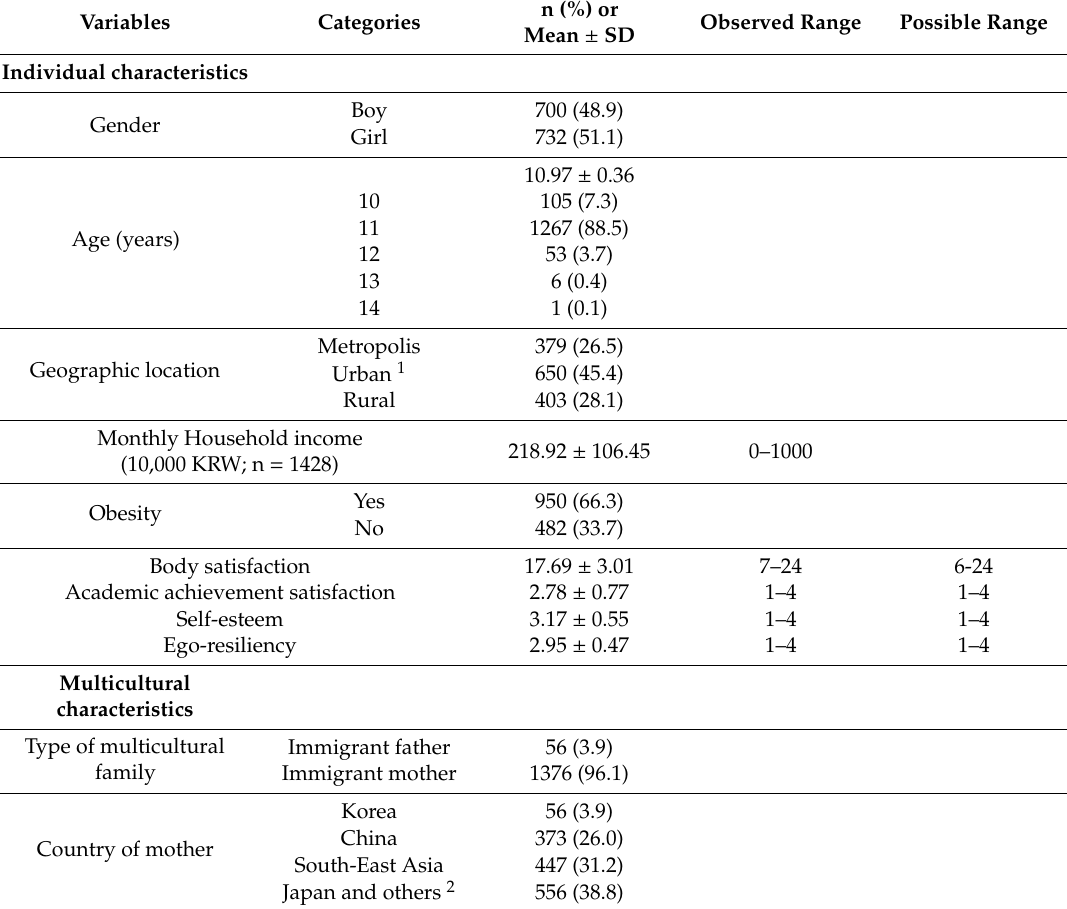
Table 1. General characteristics of multicultural adolescents according to the 2012 Multicultural Adolescents Panel Study (MAPS) data (n =